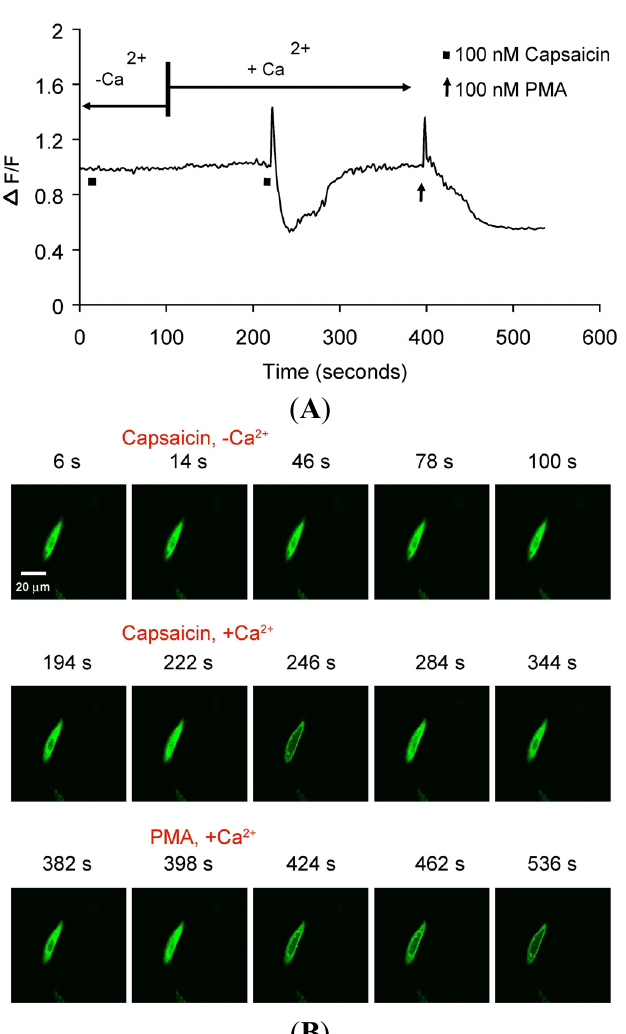
Figure 3. Translocation kinetics of PKC β II-EGFP in a single cell body of CHO cell from a culture co-transfected with PKC β II-EGFP and